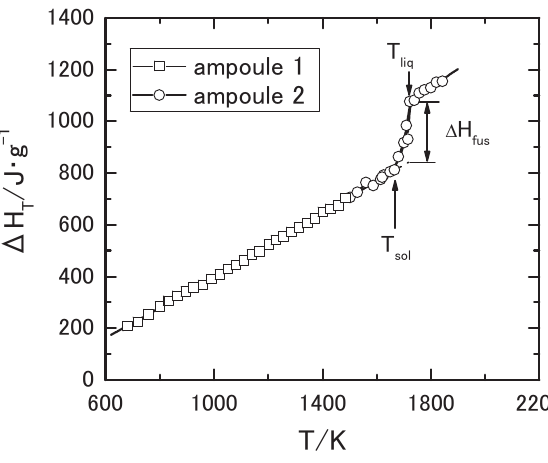
Figure 3. Heat content of SUS304 stainless